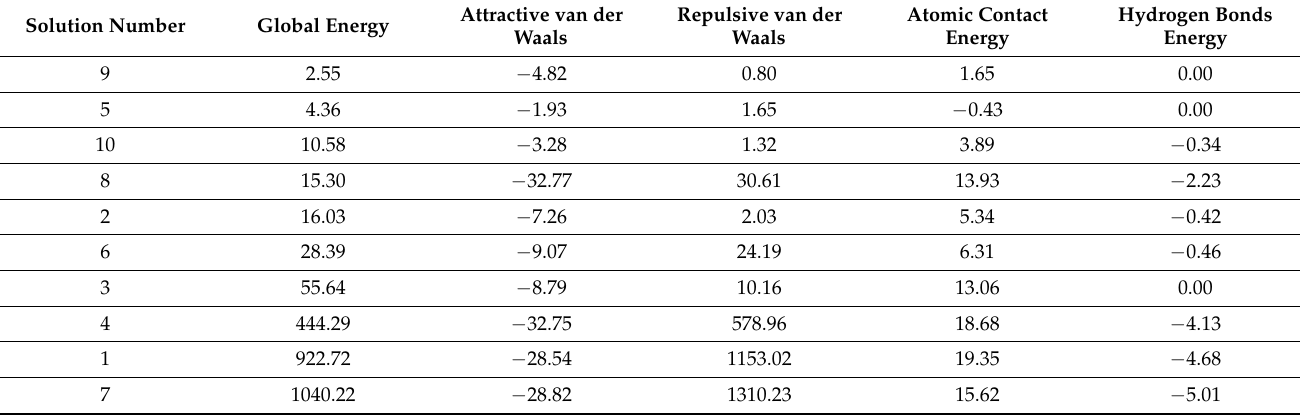
Table 12. Refined docked solution of the vaccine with MHC-II, generated by the FireDock webserver.